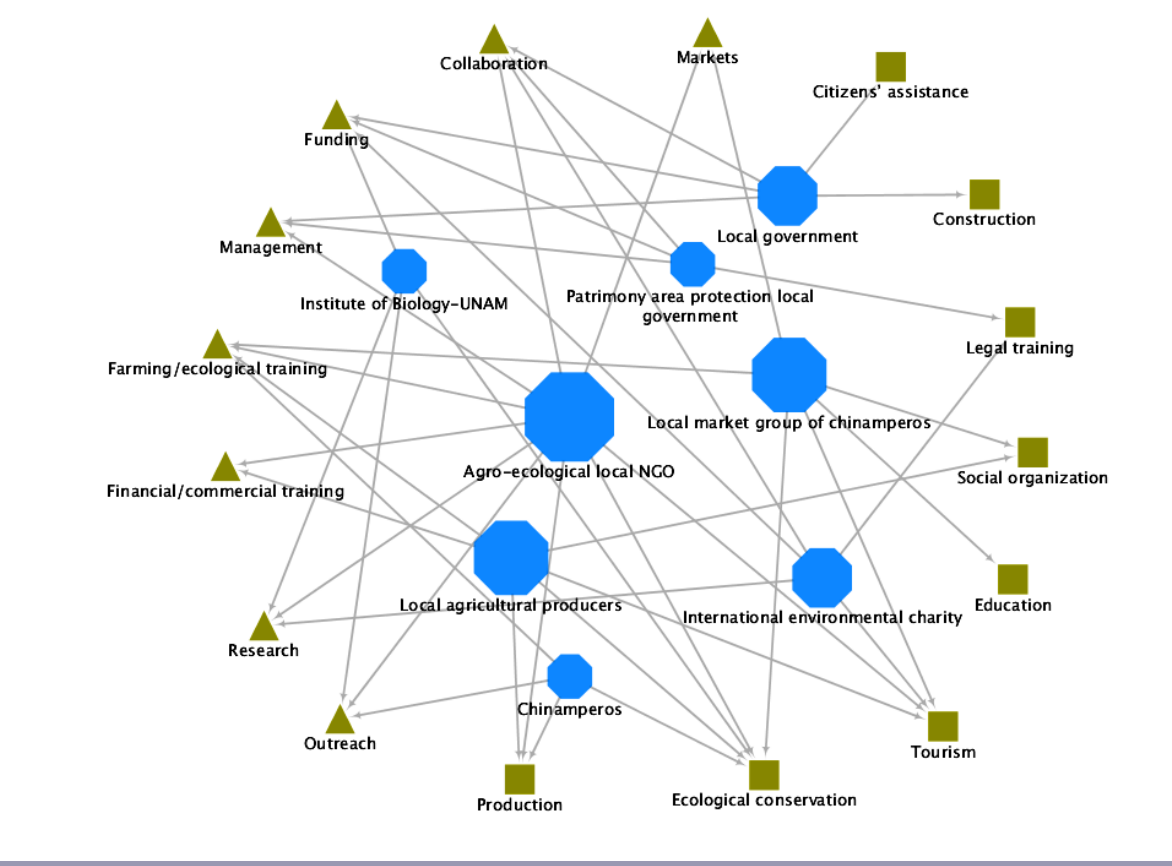
Fig. 6. Network of categories of practices (brown) and alters (blue). Triangles indicate categories of practices in which there is high participation of